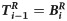
Spine features description.An ellipse is defined by its centroid, major axis (Ti−1R=BiR) and minor axis (Ti−1r=Bir). These points are connected by
vectors hi
whose length is
|hi|. From
vectors hi and
hi−1,
θi
and
ϕi
are obtained.
Θi
and
Φi
are the ellipse directions of the spine.